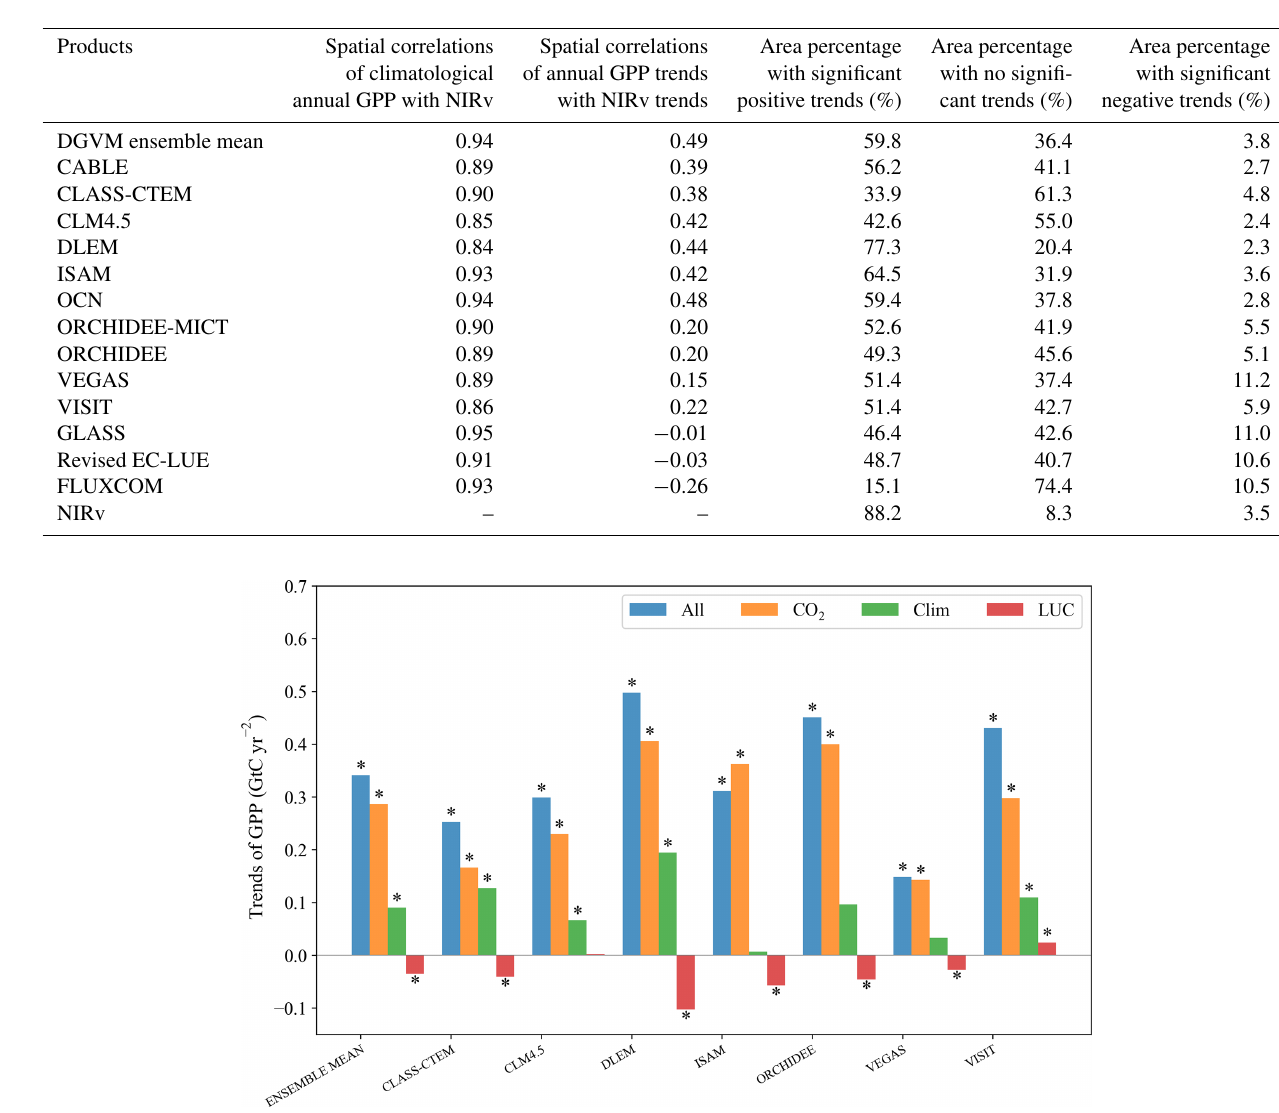
Table 3. Spatial information for NIRv and different GPP products.